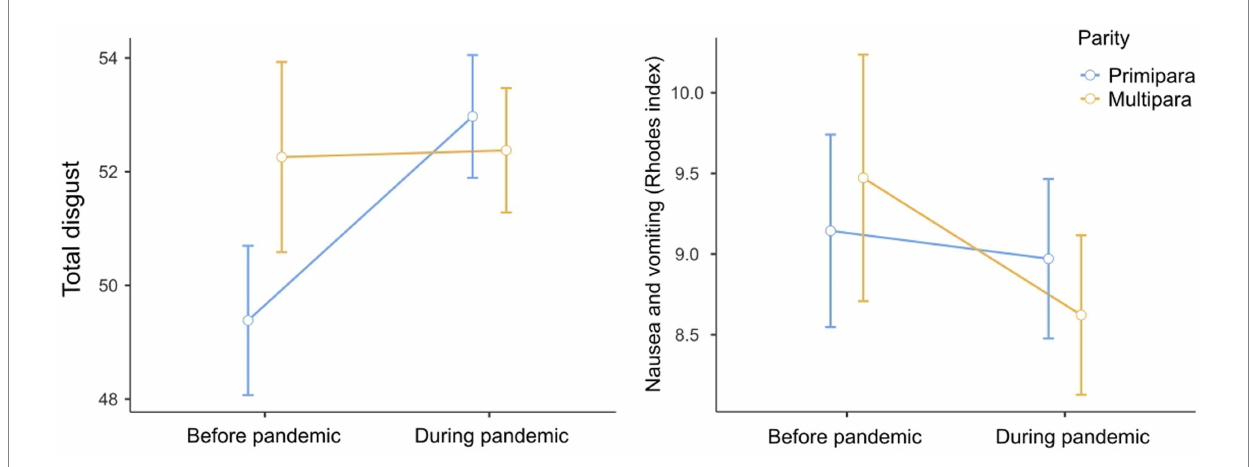
FIGURE 1 Disgust sensitivity and nausea and vomiting (mean, SE) in pregnant women before and during the COVID-19 pandemic — Stratified by parity.